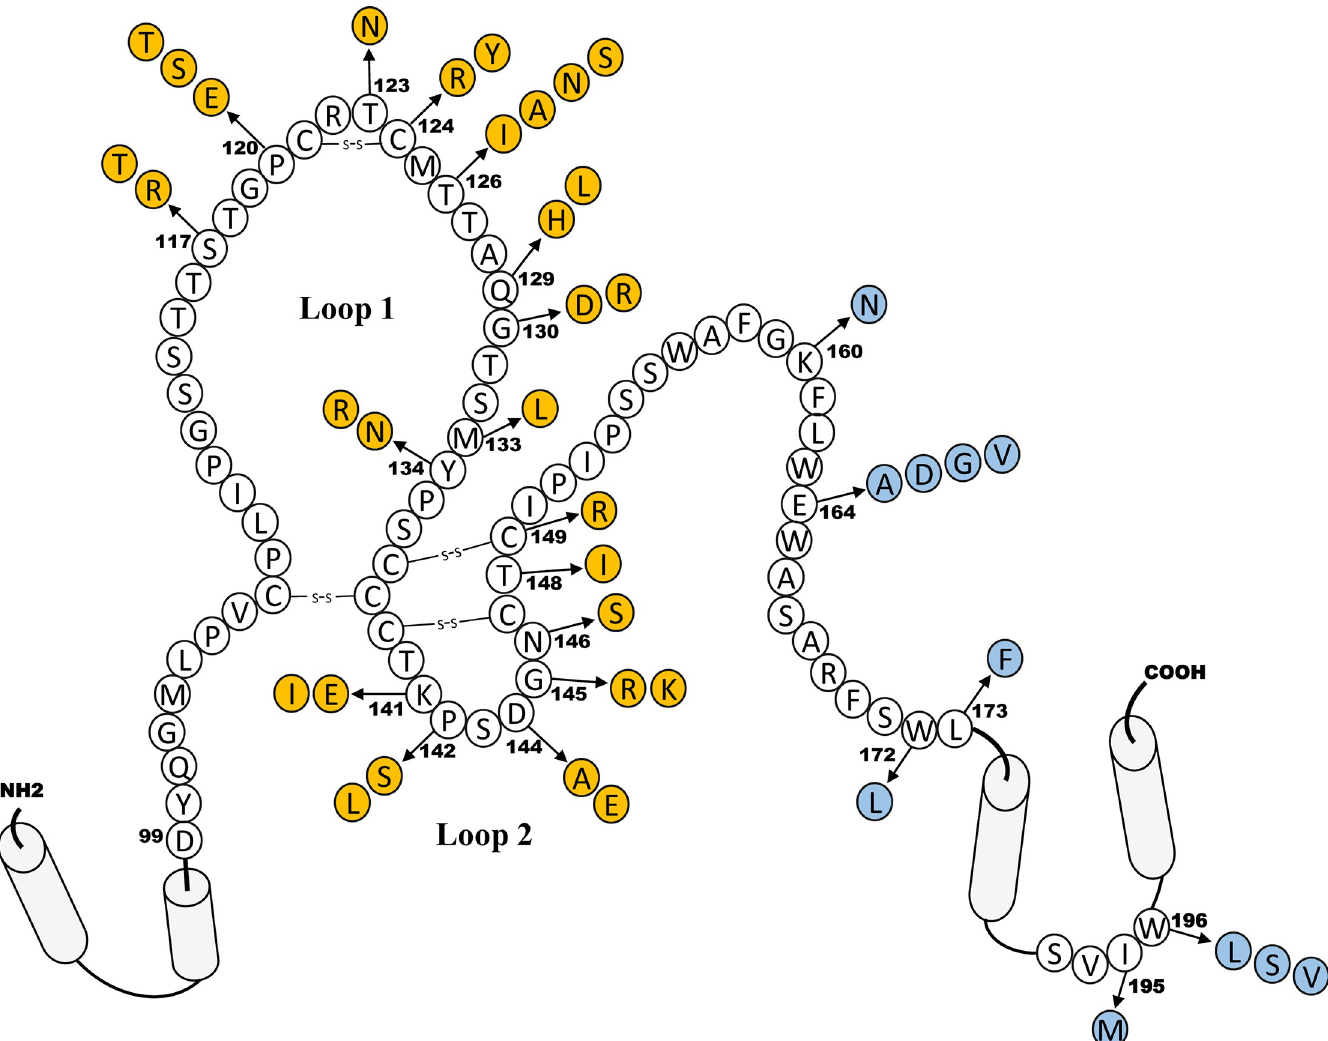
Fig 4. HBV S gene mutations investigated in this study. A schematic diagram of S antigen depicted with the four transmembrane domains and amino acid residues comprising the two loops of dominant antigenic region (Genotype D, ayw). In circles are mutations in the antigenic ‘a’ determinant (in yellow) and mutations (except K160N) in the other region of S that overlap with some viral polymerase mutations conferring resistance to nucleos(t)ide